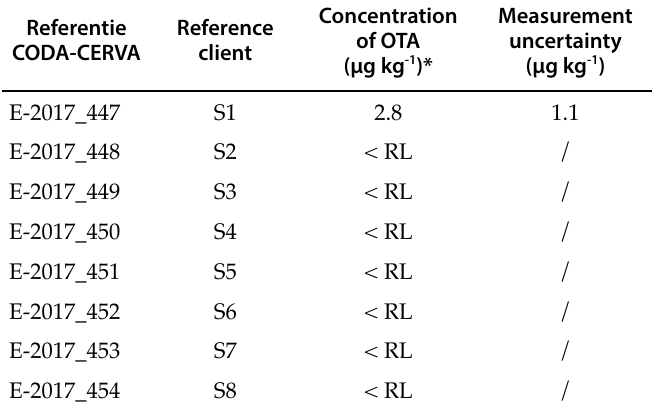
Table 6. Confirmatory results.